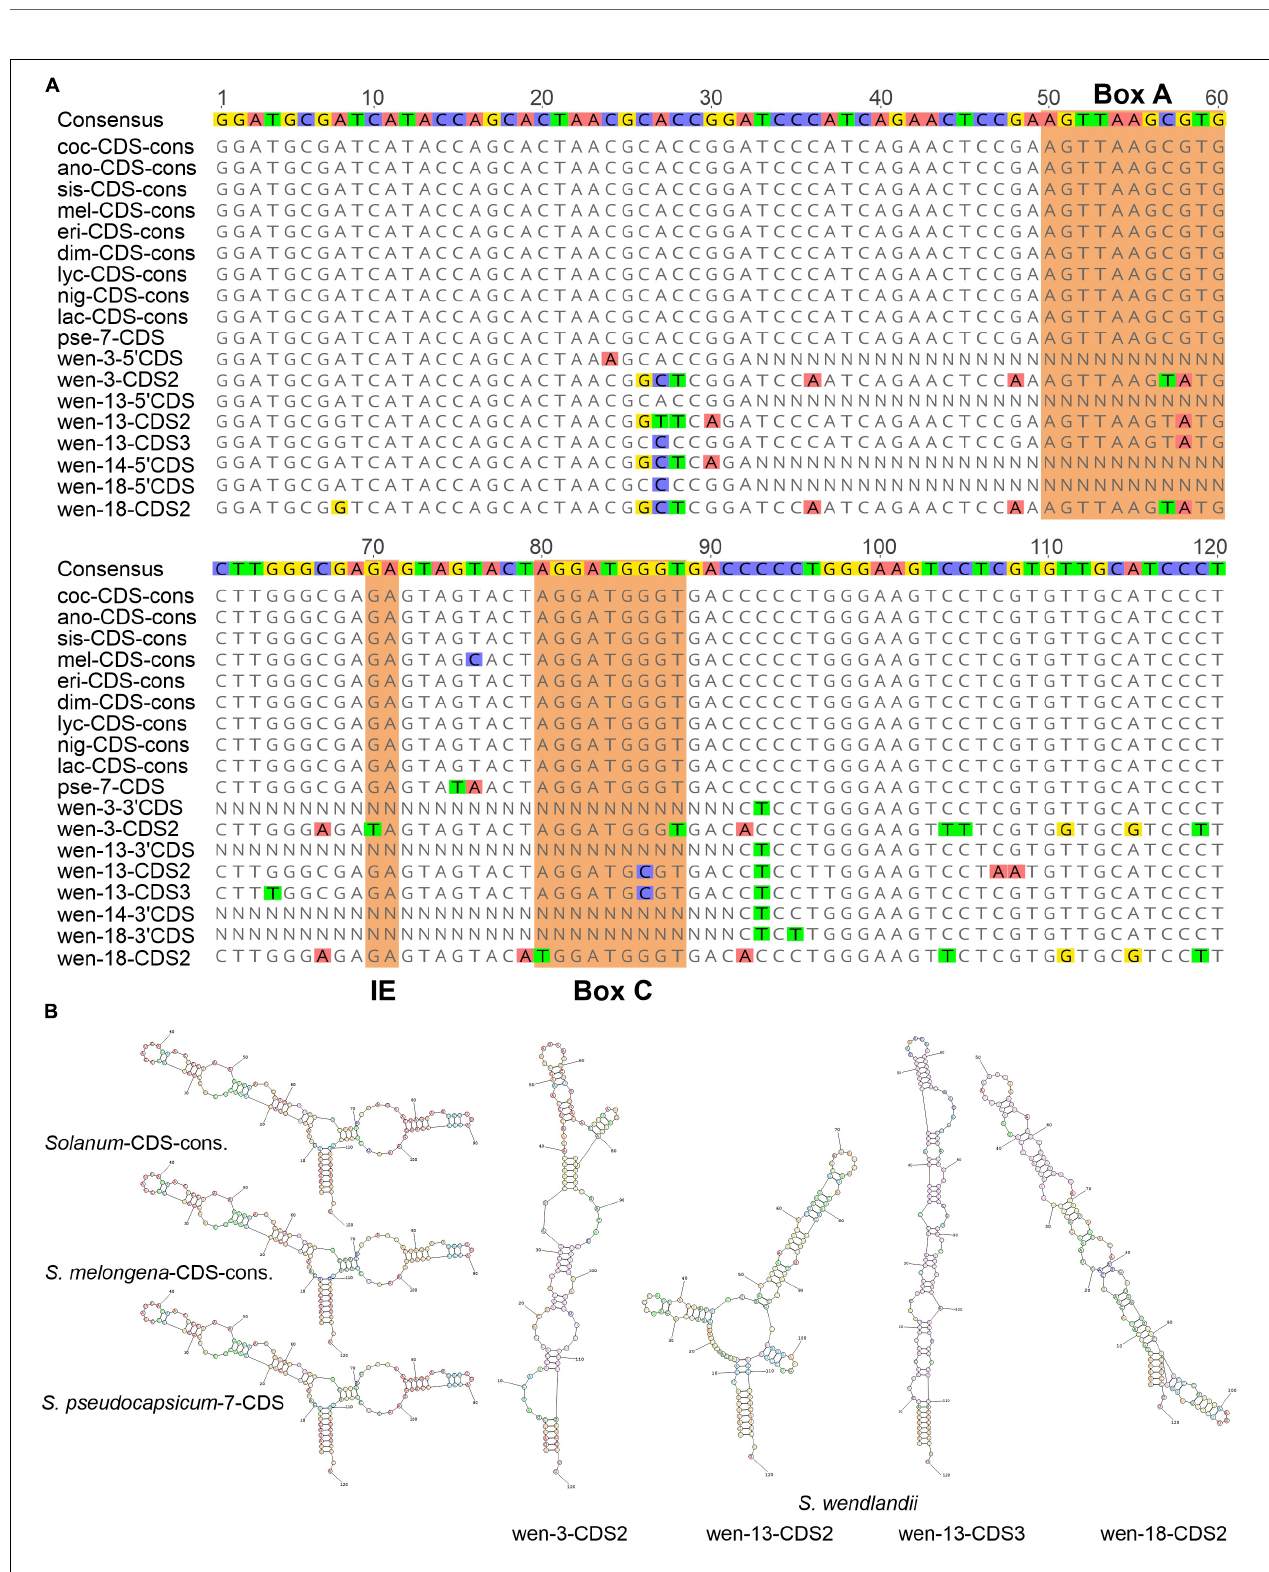
FIGURE 4 | Comparison of Solanum 5S rRNA CDS. (A) Alignment of the CDS of distantly related Solanum species and 5S rDNA clones of S. wendlandii . (B) Predicted secondary structures of 5S rRNA transcripts. Abbreviations of species names are given in Table 1 .